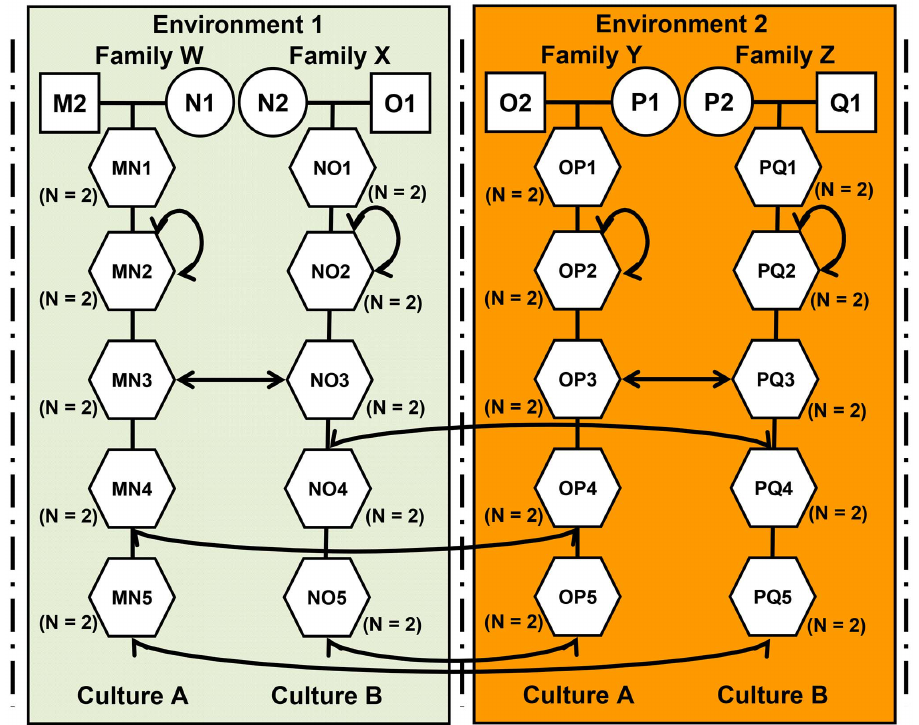
Figure 2. The ideal double pedigree protocol to study the interactions between genotype, environment and culture. This can be simplified in the lab by providing only one type of environment. Each column represents one family and hence one set of parental genes reorganized in different individual genotypes. The colored boxes represent different environments. O 1 and O 2 are siblings. This illustrates the possibility of linking families across environments. Squares and circles are male and female parents and hexagons are offspring. In this design we consider that there are two identified cultures (e.g. song dialects or languages). Sample sizes are set at two which is the minimum necessary to account for residual variance. Two-way arrows indicate partial cross-fostering among environments, families and cultures. The arrows starting and ending on the same family corresponds to controls for the effect of the manipulation where eggs or young are handled, moved over a comparable period of time, then put back in their original nest or habitat. In this cross-foster design all combinations of environment, genotype and culture can be created and replicated. Ideally, some of the cross-fosterings are performed within the same culture/environment/family to test for the manipulation effect. The cross-fosters are then used to build the matrix of cultural distances among individuals, which describes the cultural pedigree (see text). An advantage of the animal model is that it is robust enough to cope with unbalanced designs resulting from the unavoidable death of some individuals.